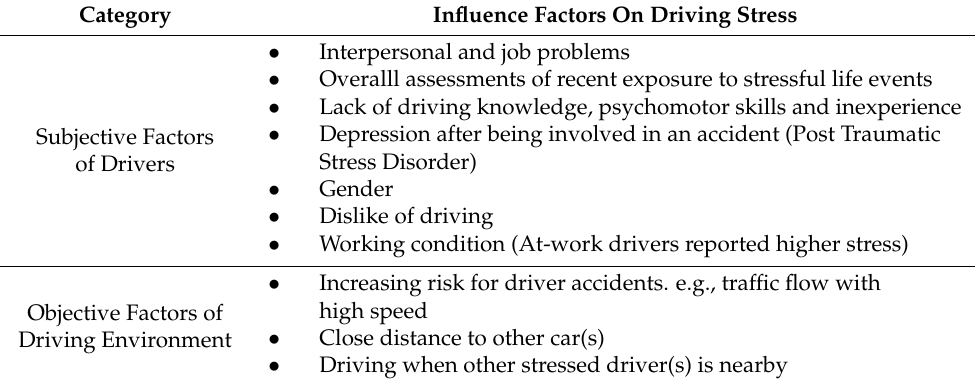
Table 4 lists some representative factors that may influence driving stress. Table 4. Influence factors on driving